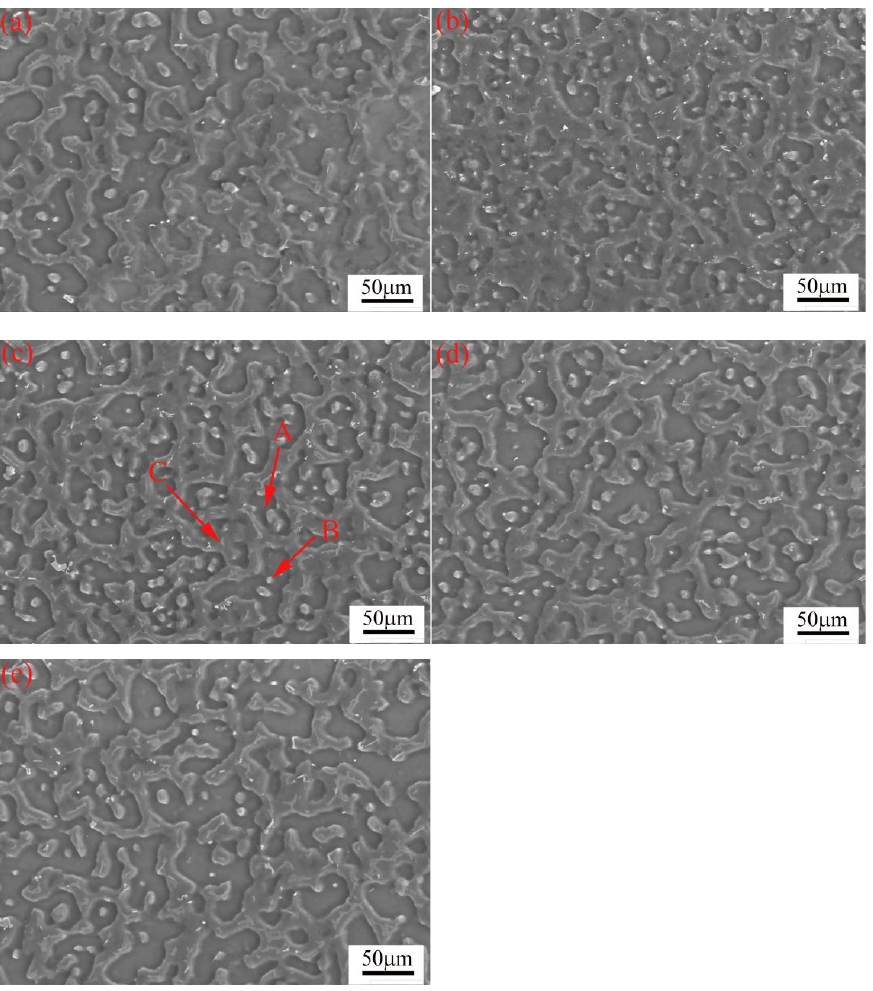
Figure 3. Microstructure of the weld area under different coating amounts under the action of magnetic field. ( a ) 1 mg/cm 2 ; ( b ) 2 mg/cm 2 ; ( c ) 3 mg/cm 2 ; ( d ) 4 mg/cm 2 ; ( e ) 5 mg/cm 2